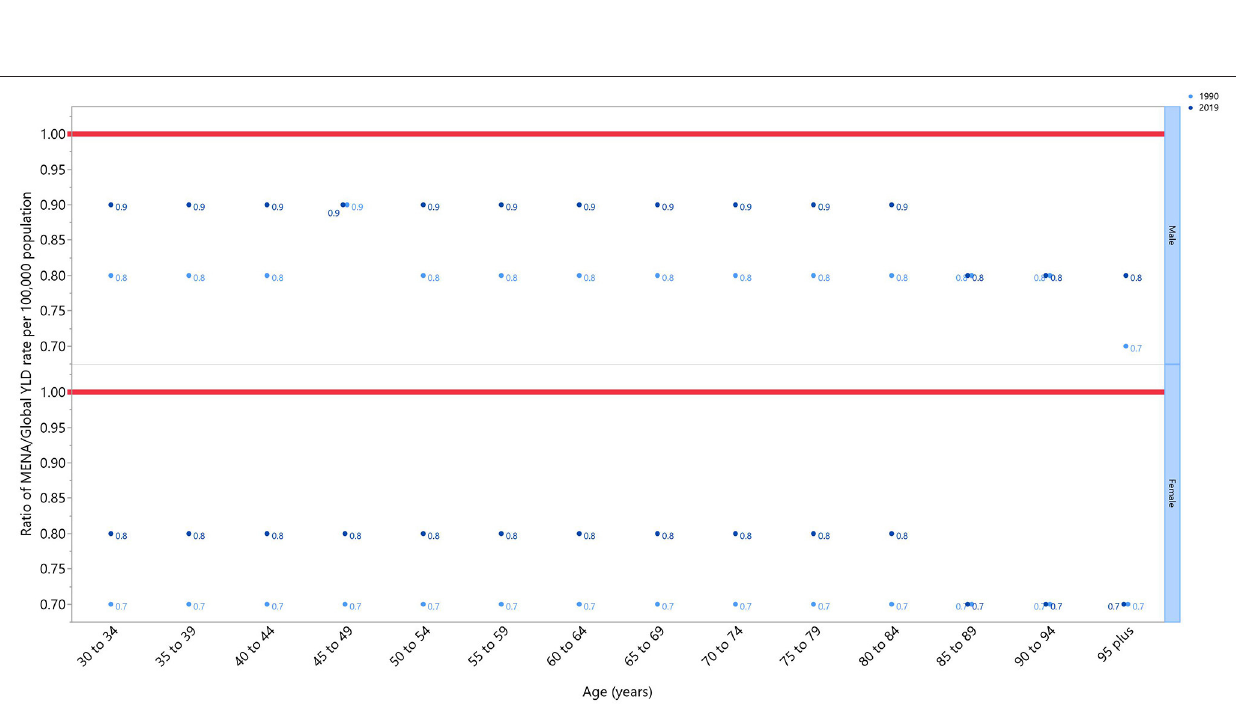
Frontiers in Medicine | www.frontiersin.org